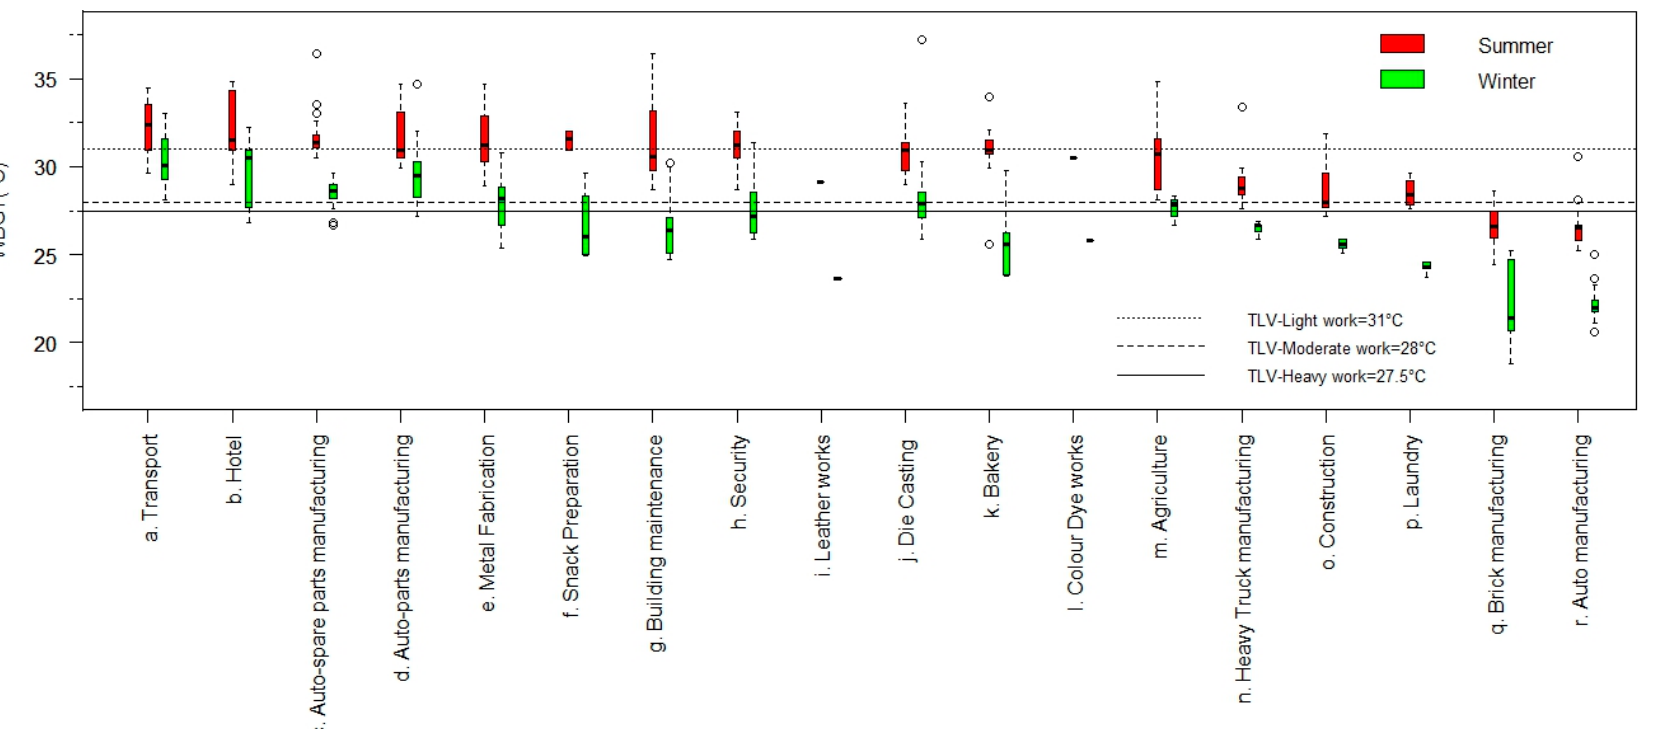
Figure 1. Wet bulb globe temperature ( WBGT) profiles across various workplaces during cooler (2012) and hotter (2013) seasons in India. The three lines across the graph represent the Threshold Limit Values (TLV) for each of the work categories (31 °C for light work, 28 °C for moderate and 27.5 °C for heavy work categories).